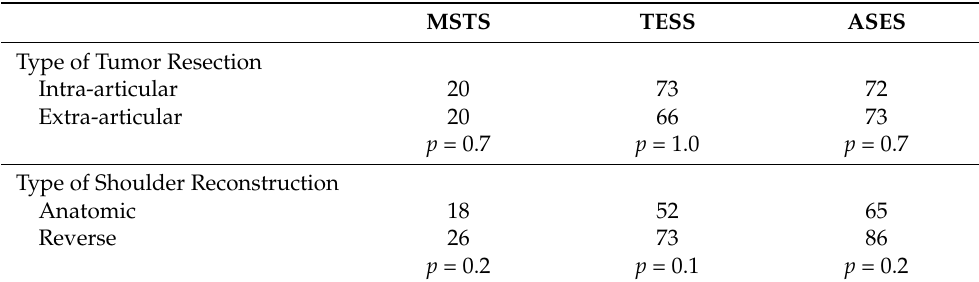
Table 3. Median MSTS, TESS and ASES scores differentiated by type of tumor resection and shoulder